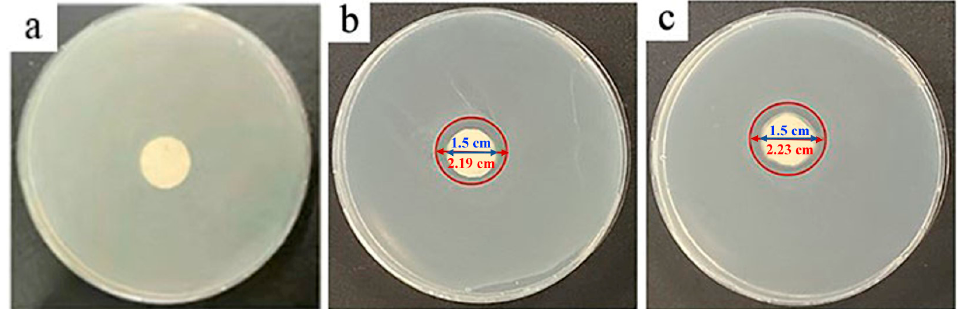
Figure 4. The inhibition zone of nanofibers (PCL@PN ( a ), PN@6 wt%Ag-2 h ( b ), and PN@8 wt%Ag-2 h ( c )) on Escherichia coli after 24 h.